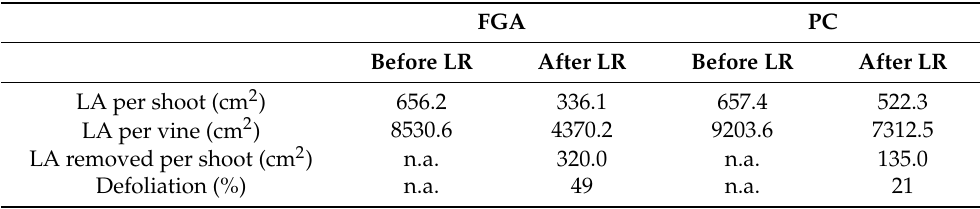
Table 2. Average leaf area (LA) per shoot and per vine (n = 20) assessed both in FGA and PC before and after leaf removal (LR) at BBCH62. Average LA removed and % of defoliation are shown as well (n.a.; not applicable).